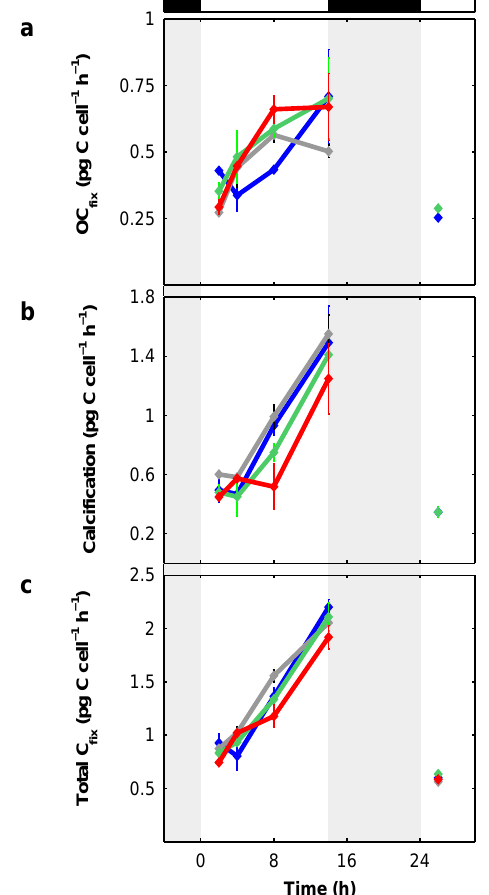
Fig. 2. Carbon fixation rates of Emiliania huxleyi determined for each period of time between consecutive sampling points. (a) or- ganic carbon fixation per cell per h, (b) calcification per cell per h and (c) total carbon fixation per cell per h. For each period of time the data point marks the end of the incubation. Each CO 2 level has duplicate measurements. Vertical error bars represent the range of the data and the lines connect the averages of each time point. Line and color coding as in Fig. 1.